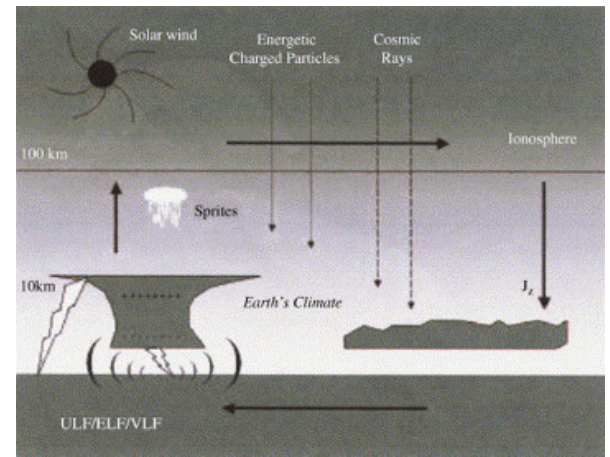
Figure 7. Concept diagram for topics in the SPECIAL network (from Rycroft and Füllekrug, 2004).